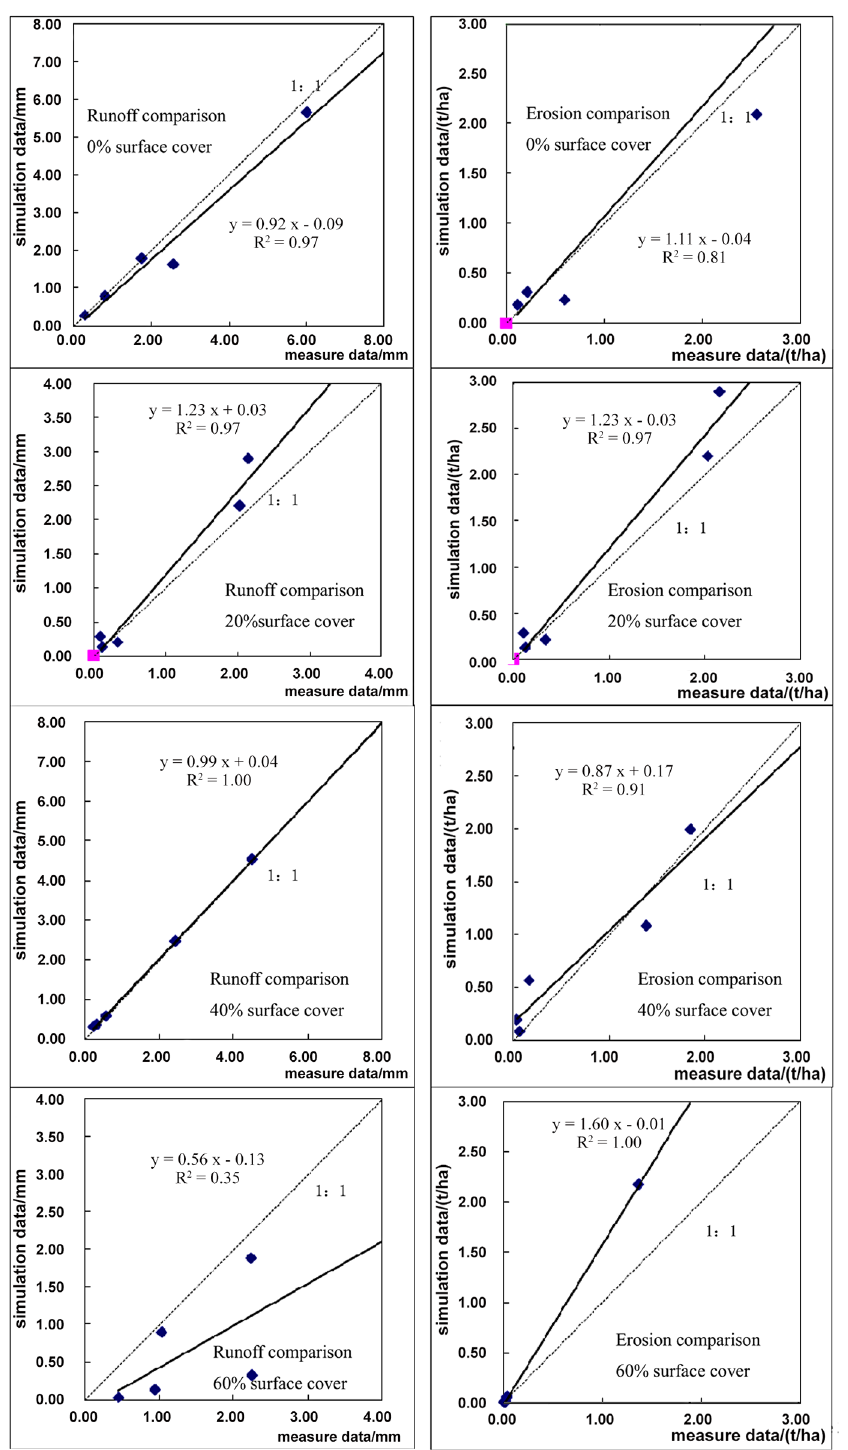
Fig 2. Runoff and Soil Erosion Comparison of Artificial Plots.